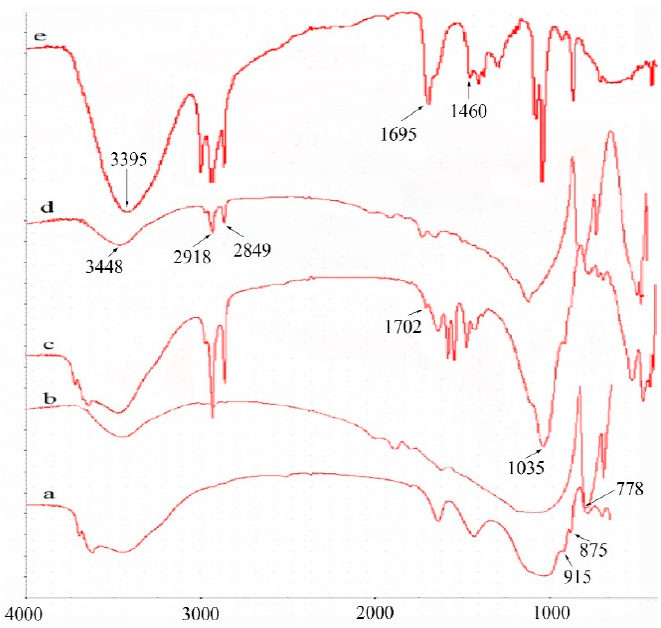
Figure 1. The FTIR spectra of ( a ) unmodified bentonite, ( b ) unmodified silica, ( c ) modified bentonite, ( d ) modified silica, ( e ) stearic acid.